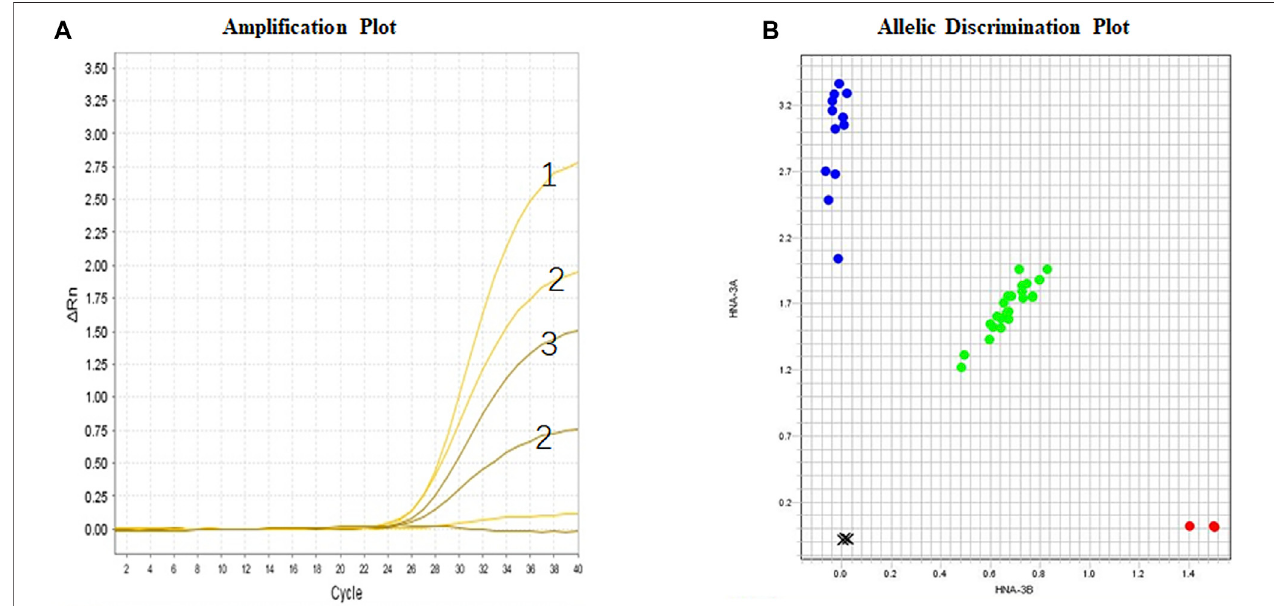
FIGURE 2 | Real-time PCR for SLC44A2 genotyping (CTL2 system). (A) Ampli fi cation Plot: HNA-3B-VIC channel; HNA- 3A-FAM channel; Sample No. 1 is SLC44A2*1/1 ; Sample No. 2 is SLC44A2*1/2 ; Sample No. 3 is SLC44A2*2/2 ; (B) Allelic discrimination plot for individual samples using puri fi ed DNA.